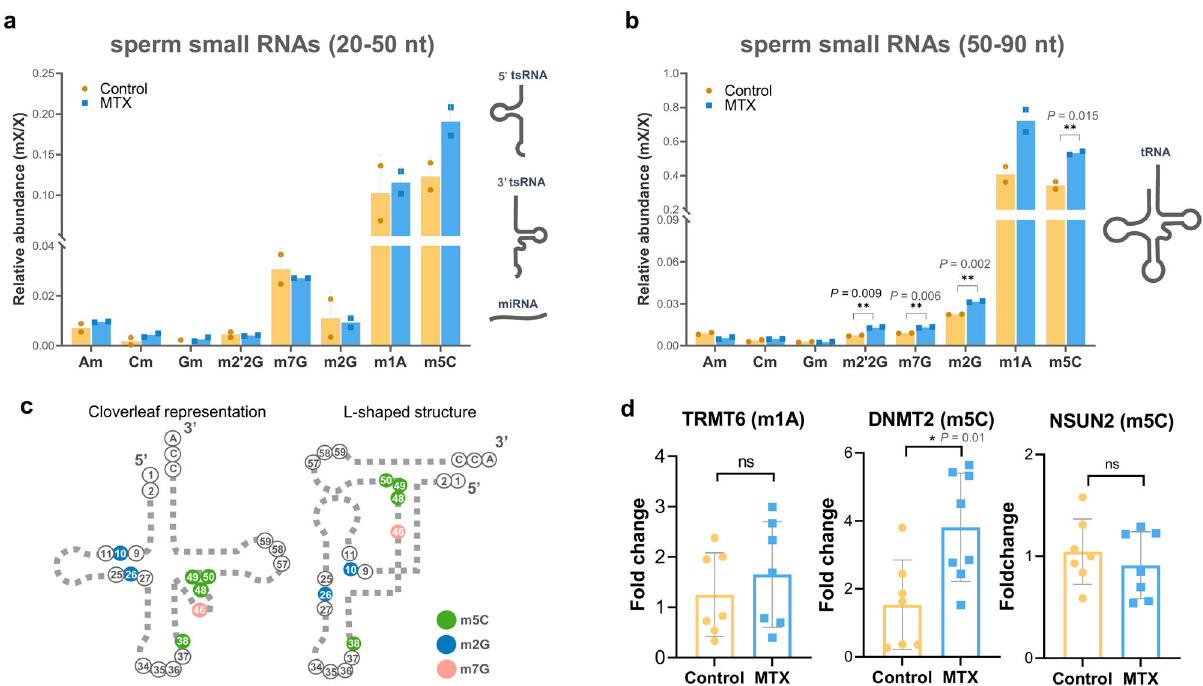
Fig. 5 | Paternal MTX injection alters smallRNA modi fi cations in sperm tRNA fraction and the testicular expression of RNA-methyltransferases. Histogram comparing sperm RNA methylations on control and MTX analyzed by UHPLC-MS- MS in 50 – 90 nt ( a ) and 20 – 50 nt ( b ) fractions. Data represent two biologically independent replicates ( n =2) composed by RNA isolated from 9 males ’ sperm. Statisticalanalysiswasperformedbytwo-tailedunpaired t-student ’ test.Valuesare mean ± S.D. ( c ) Schematic representation of modi fi ed nucleotides in the tRNA at